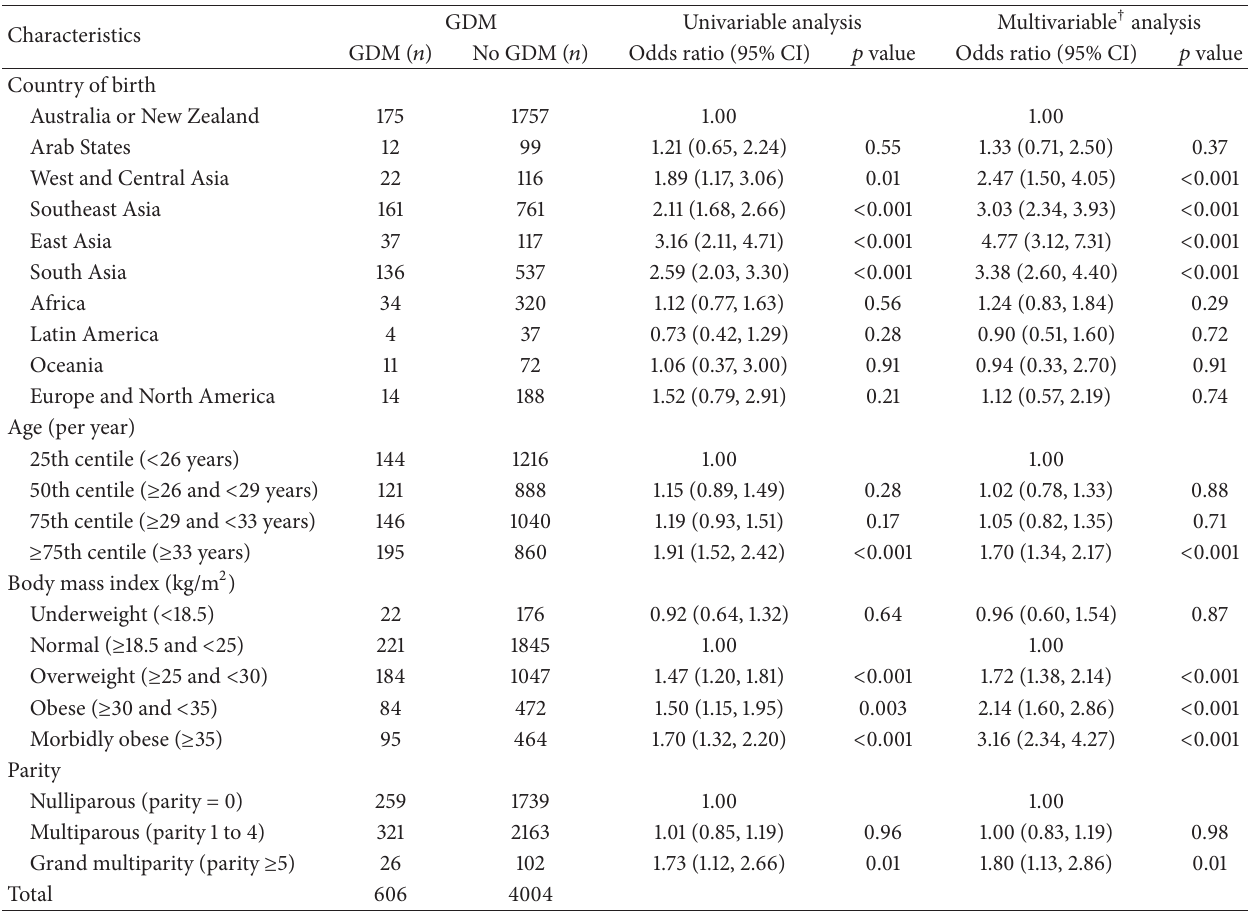
Table 3: Results of univariable and multivariable logistic regression for presence or absence of gestational diabetes mellitus (GDM) in 4610 women at Sunshine Hospital,